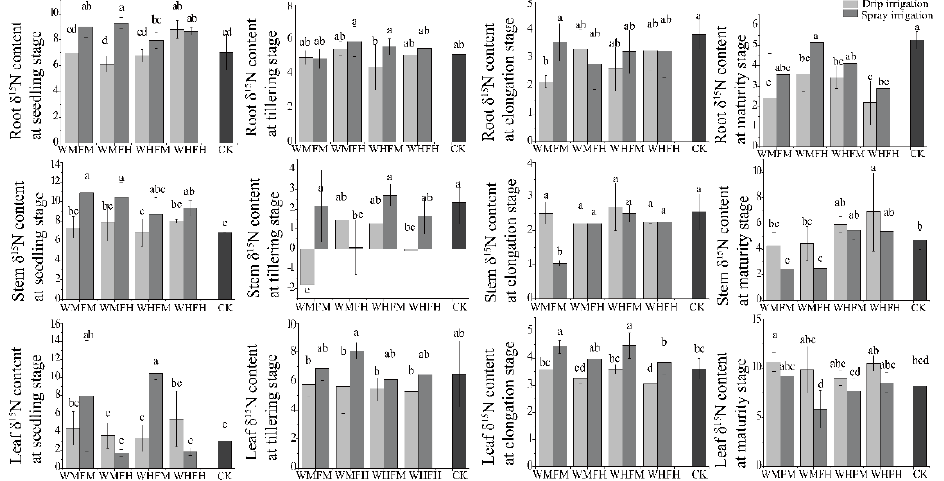
Figure 3. Nitrogen isotope ( δ 15 N) content in ( top panels) roots, ( center ) stems, and ( bottom ) leaves of sugarcane in (left to right) the seedling, tillering, elongation, and maturity stages under different water-fertilizer treatments (for treatment abbreviations, see Table 1) (Different letters a, b, c and d in the figure indicate significant differences between treatments).